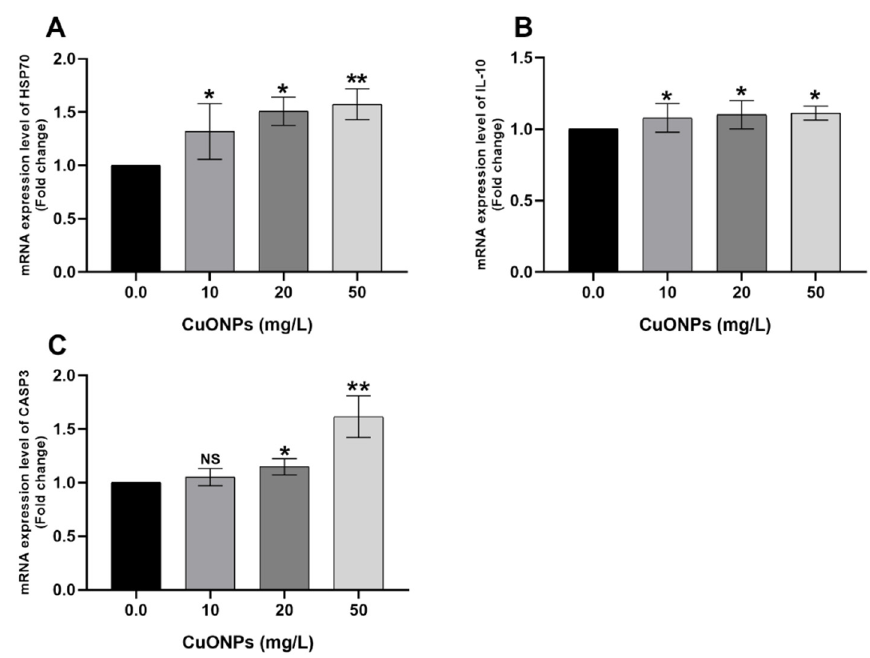
Figure 3. mRNA transcription profile of HSP70 ( A ), IL-10 ( B ), and CASP3 ( C ) genes in the gills of Nile tilapia juveniles after exposure to sub-lethal concentrations of CuONPs (0 mg/L, 10 mg/L, 20 mg/L and 50 mg/L) for 25 days. The values are expressed as mean ± SEM ( n = 9). Asterisk (*) ( p < 0.05) and (**) ( p < 0.01) indicate significant differences between the exposure groups compared with the control group. NS indicates non-significant